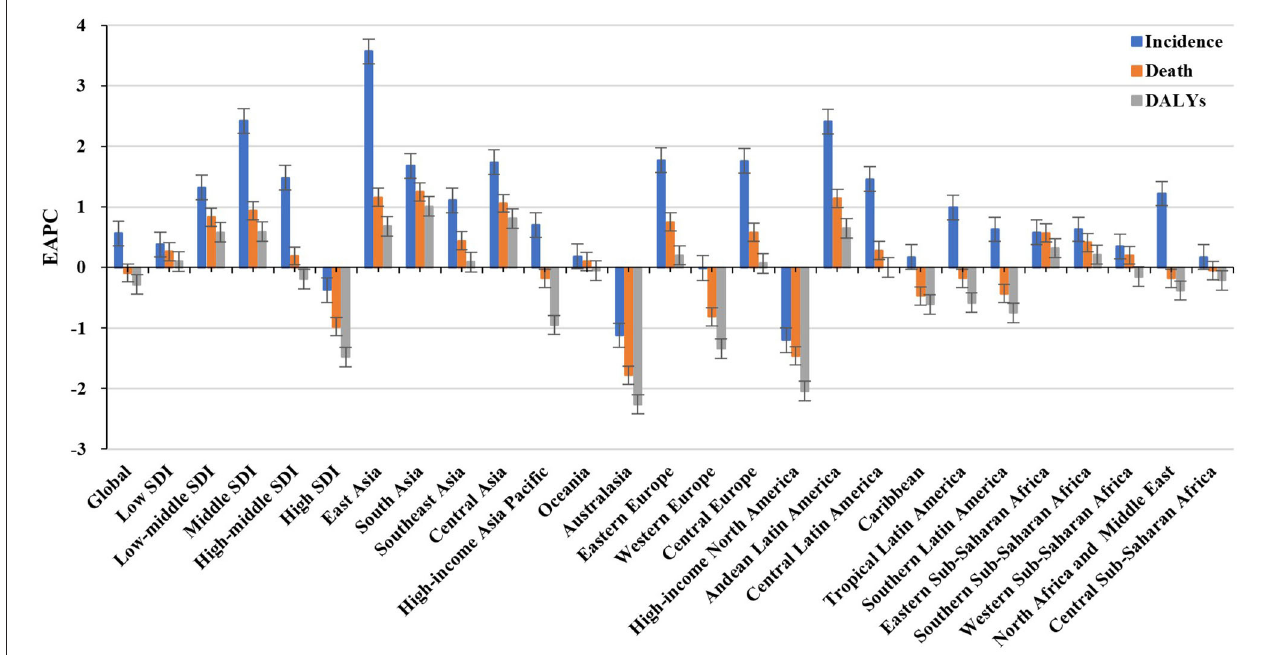
FIGURE 1 | Trends in the incidence, death, and DALYs of non-Hodgkin lymphoma in the globe, SDI areas, and geographic regions from 1990 to 2019. SDI, sociodemographic index; DALYs, disability-adjusted life years.